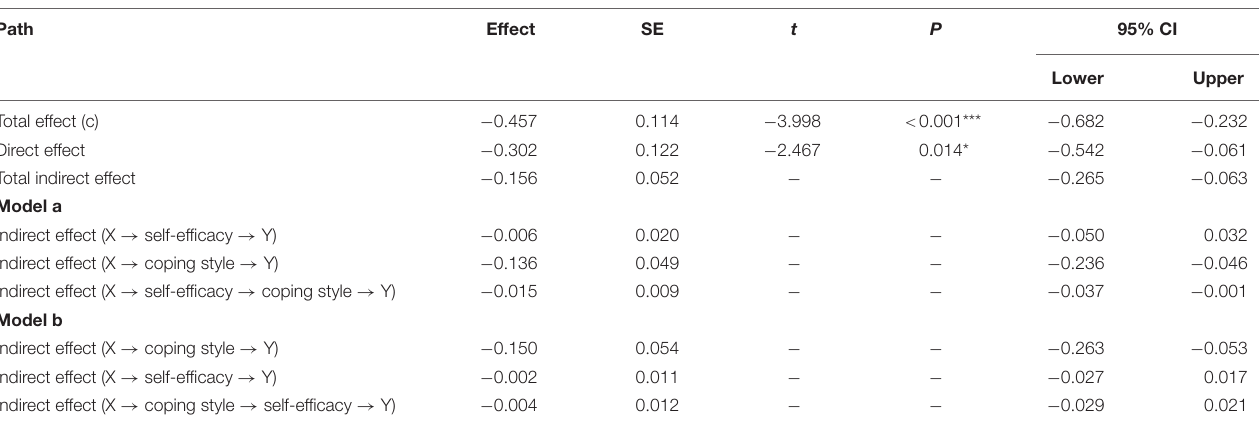
FIGURE 2 | Serial mediation model. (A) Psychological flexibility → self-efficacy → coping style → pediatric vaccine hesitancy. (B) Psychological flexibility → coping style → self-efficacy → pediatric vaccine hesitancy. Numbers associated with a, b, c, and c (cid:48) are unstandardized regression coefficients. * P < 0.05, ** P < 0.01, *** P < 0.001. TABLE 3 | Bootstrap results of the serial mediation